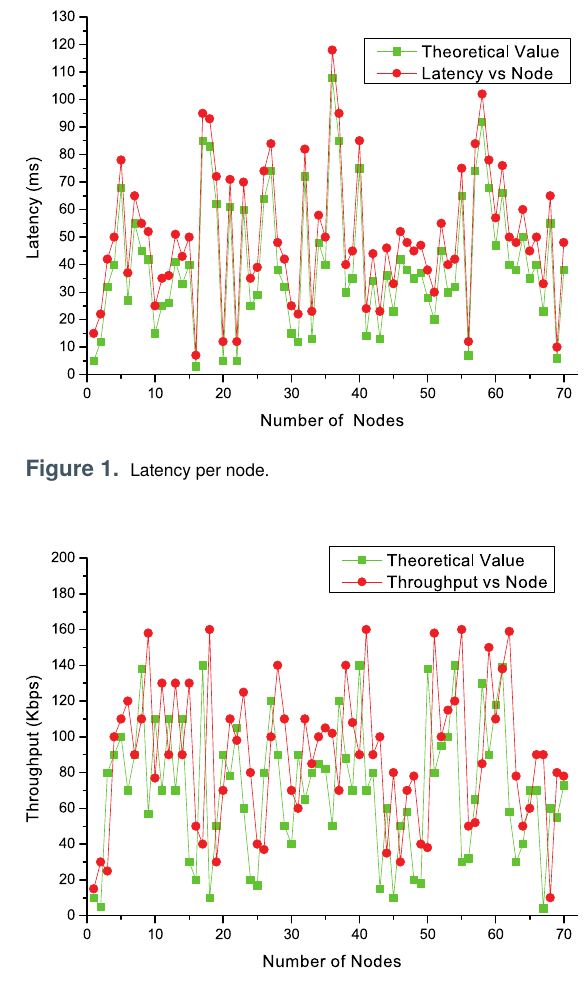
Figure 2. Throughput per